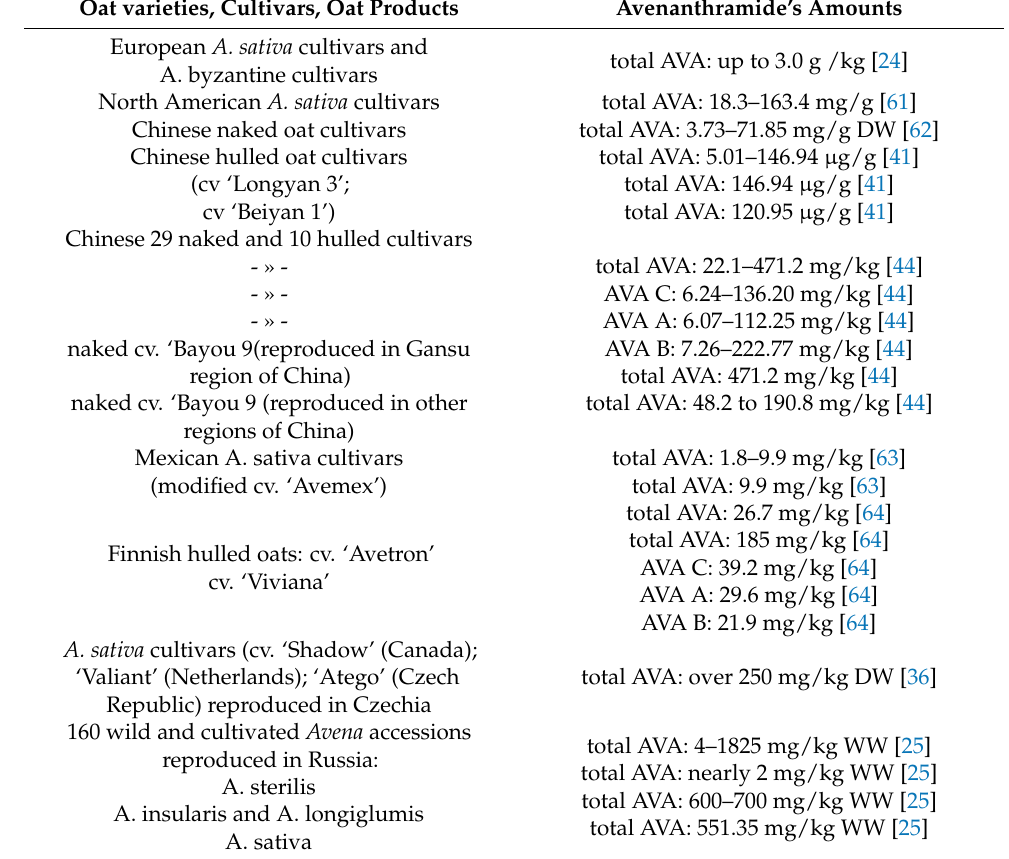
Table 3. Avenanthramide’s contents in oat varieties, cultivars and oat products. Oat varieties, Cultivars, Oat